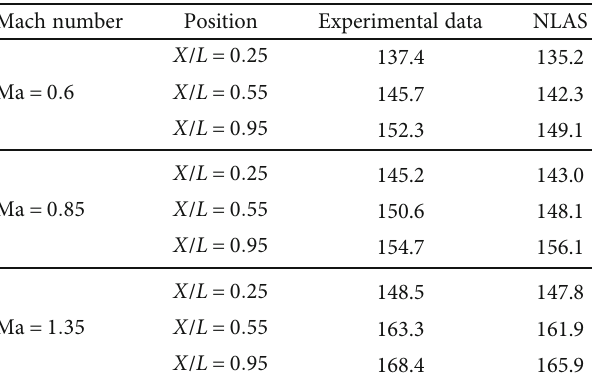
Table 1: Comparison of the highest sound level